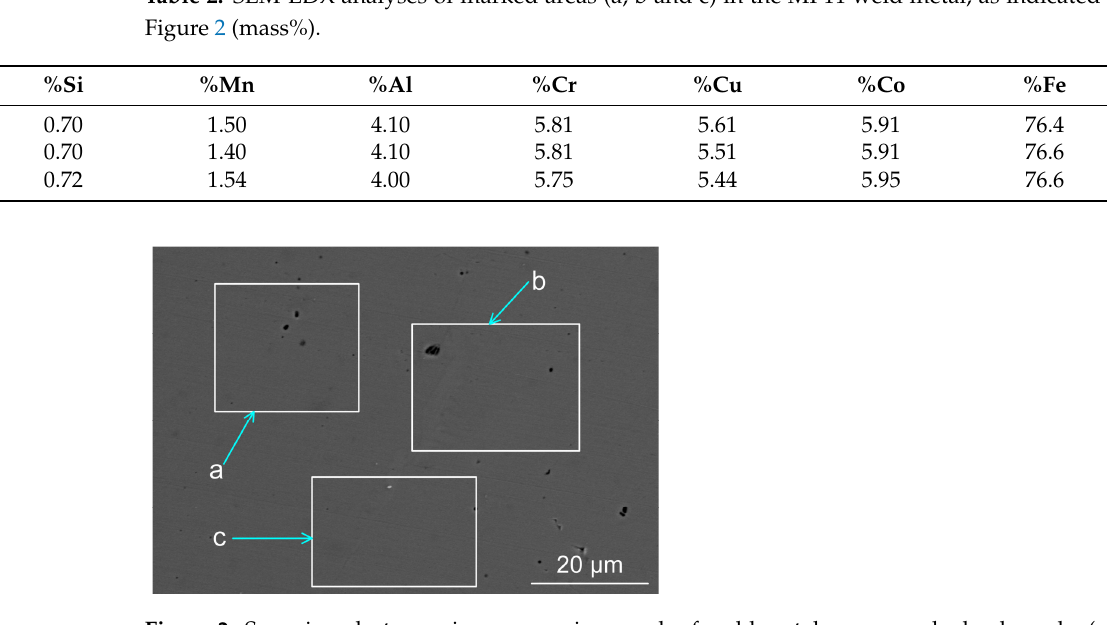
Table 1. Bulk chemical composition of weld metals (mass%).